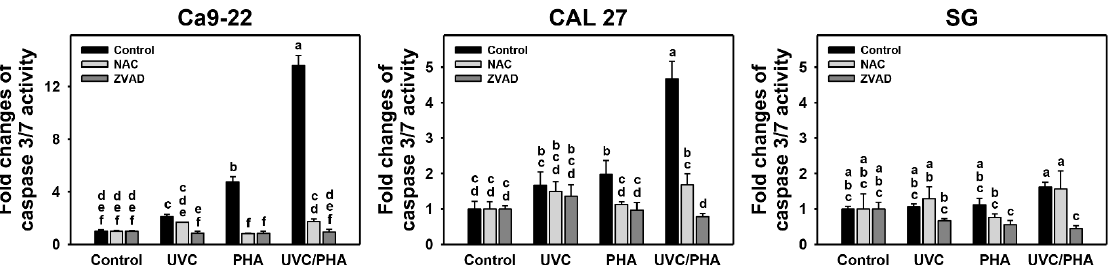
Figure 4. UVC/PHA-induced Cas 3/7 activity in oral cancer cells. In the presence or absence of NAC or ZVAD, oral cancer and normal (SG) cells were grouped into four treatments, i.e., control, UVC, PHA, and UVC/PHA, for 24 h. The doses of UVC and PHA treatments were 8 J/m 2 and 0.8 μ M, respectively. For comparison, treatments labeled with different letters (a to f) produced significantly different results ( p < 0.05). Data are presented as mean ± SD ( n = 3 independent experiments, with each experiment performed in three replications).